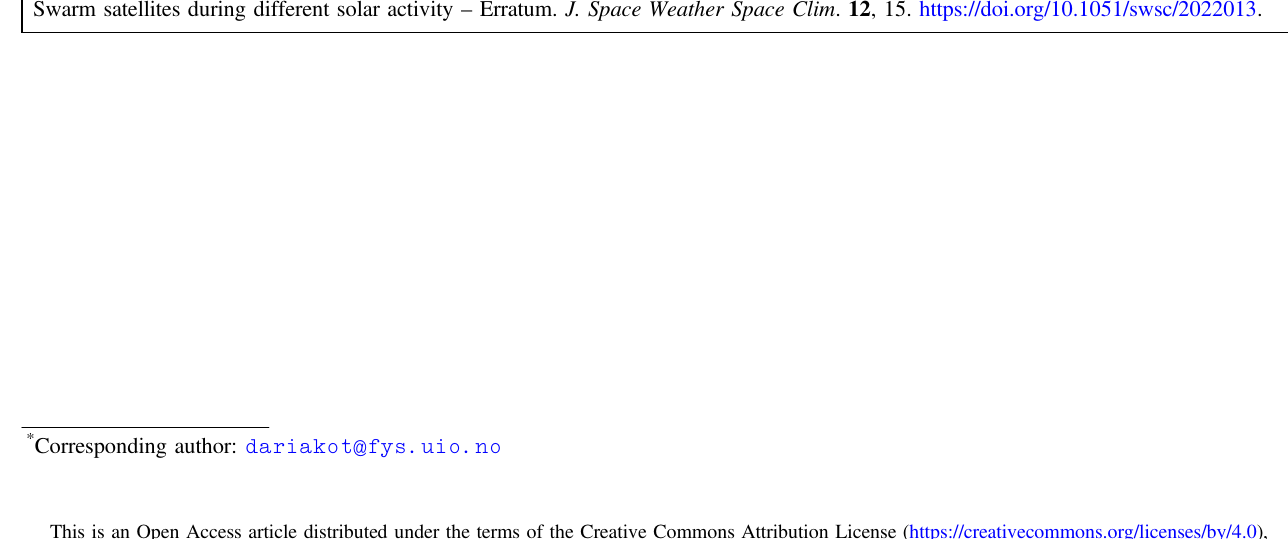
“ Fig. 1 . Box-plot with whiskers of different plasma parameters based on data from Swarm A in the Northern hemisphere (NH, shown in blue and green) and in the Southern hemispheres (SH, shown in orange and red) during high (HSA, shown in blue and orange) and low solar activity (LSA, shown in green and red) in different regions: (a) equatorial (low) latitudes; (b) mid-latitudes; (c) high latitudes (auroral oval); (d) polar caps. The low- est and highest points on the box-plot (i.e., the boundary of the lower and upper whisker) are the minimum and maximum values of the data set (excluding any outliers). The box is drawn from lower (25%) to upper (75%) quar- tile percentiles with a horizontal line to denote the median value.